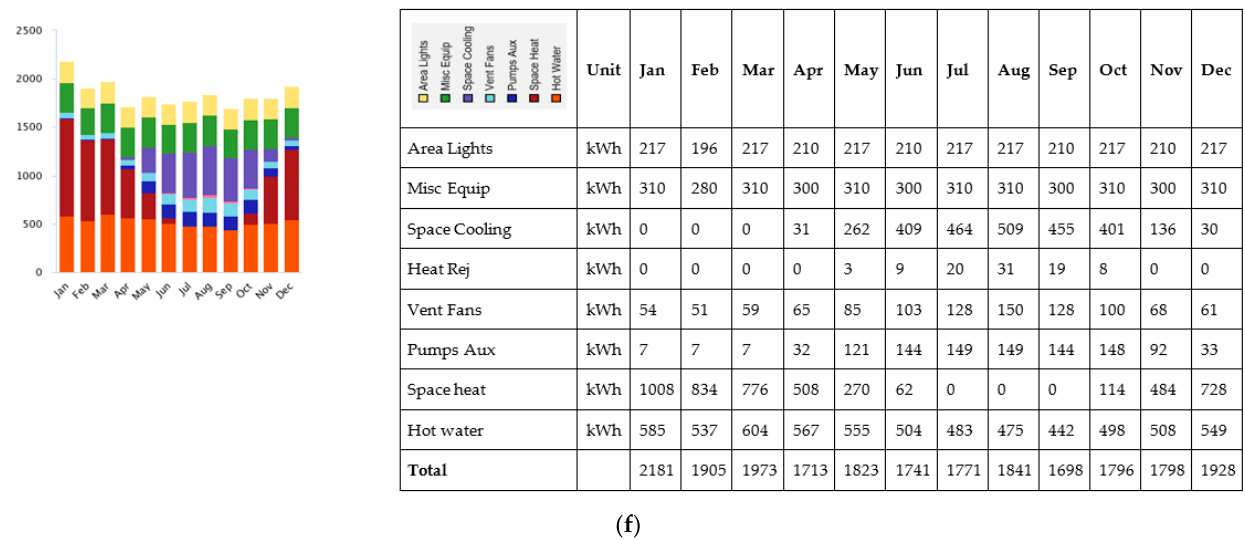
Figure 9. Monthly energy performance values (kWh) of the designed building types with sandwich